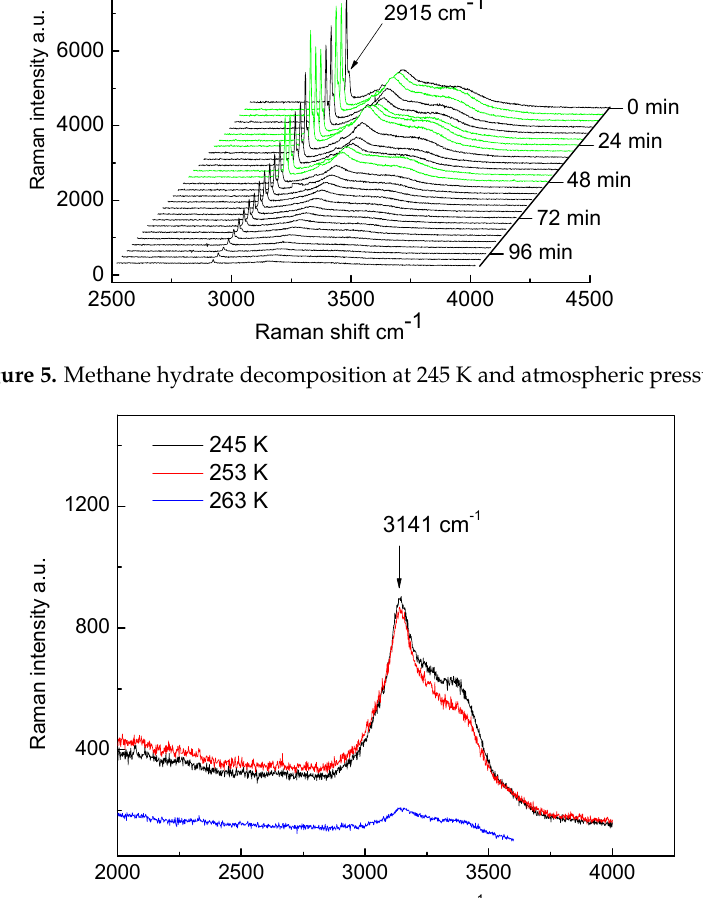
Crystals 2019 , 9 , x FOR PEER 9 of 17